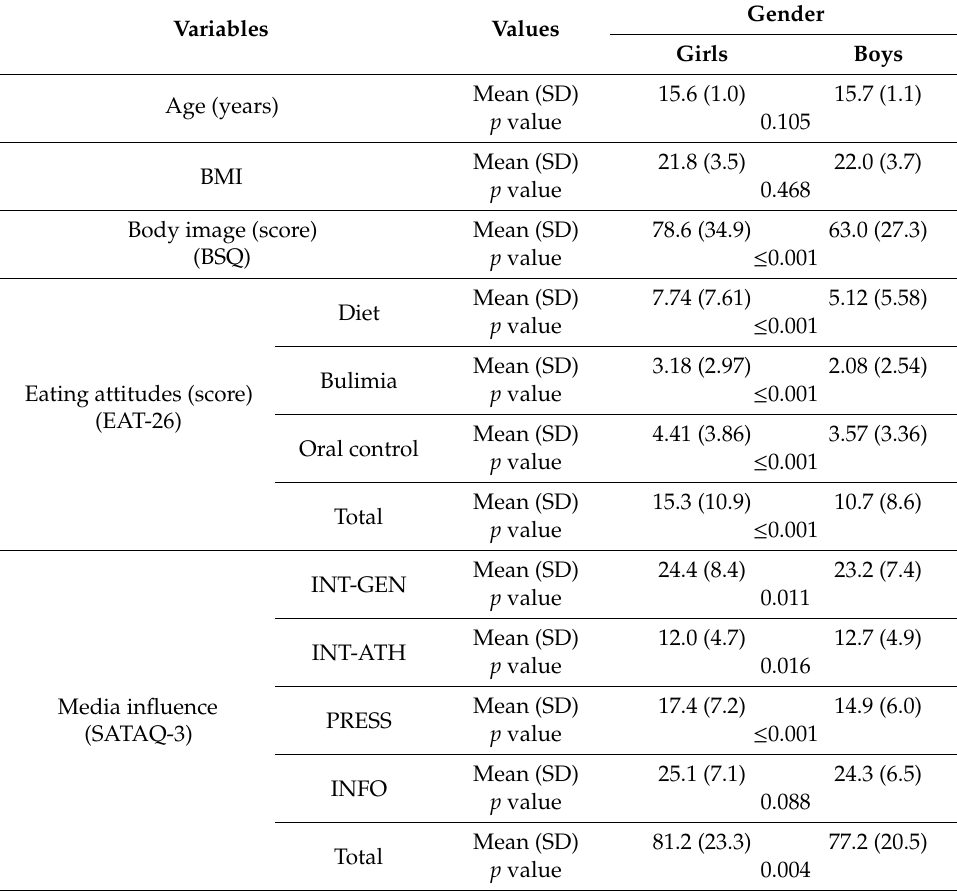
Table 1. Comparison of quantitative variables in adolescents aged between 14 and 18 years, by